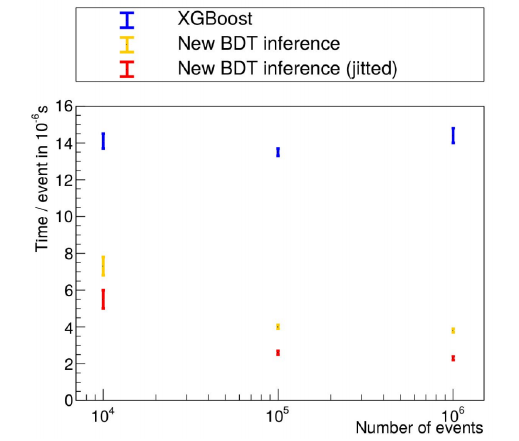
Figure 5. Benchmark of fast BDT inference in TMVA using model with 500 trees, maximum depth of three and ten input variables